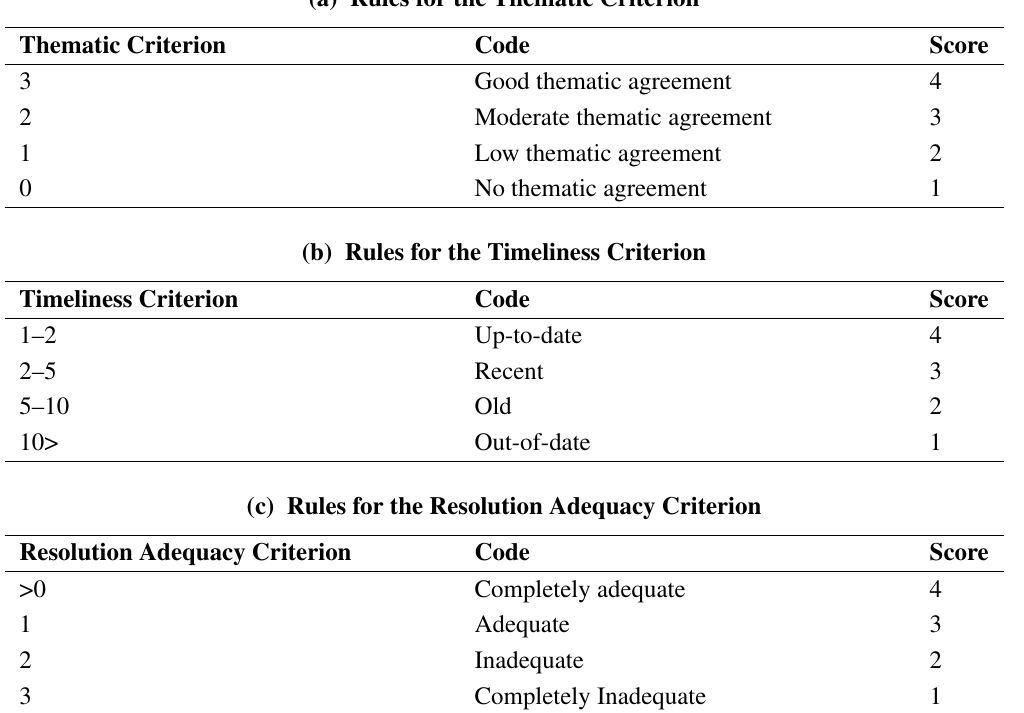
Table 3. Systematic recoding rules for the four cropland criteria used in the multi-criteria analysis. Each criterion is recoded in a four-level score ranging from